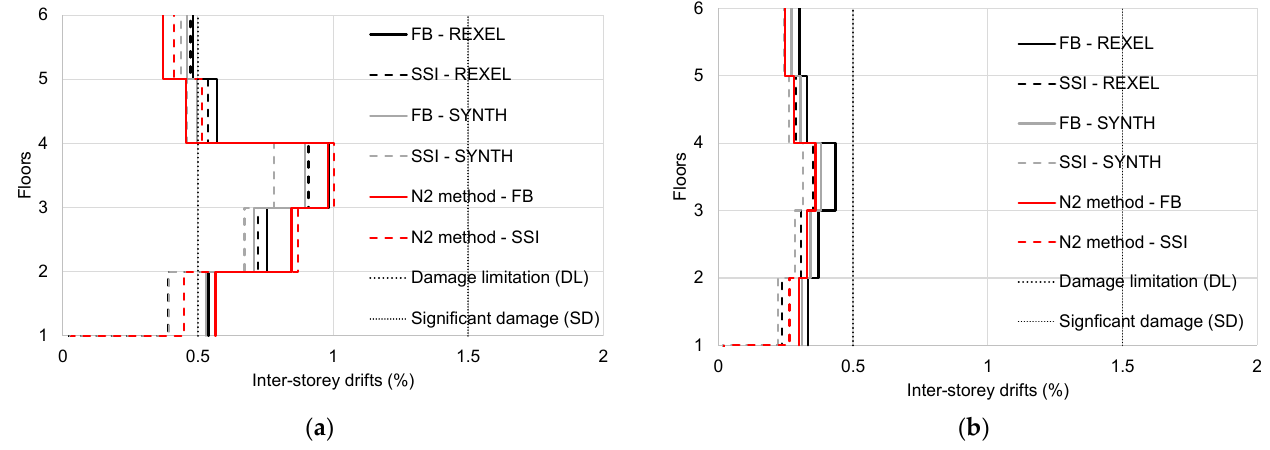
Figure 18. Comparison of inter-story drifts for: ( a ) X-direction, PGA = 0.215 g and ( b ) X-direction, PGA = 0.10 g. Figure 19. Comparison of inter-story drifts for: ( a ) Y-direction, PGA = 0.215 g and ( b ) Y-direction, PGA = 0.10 g.